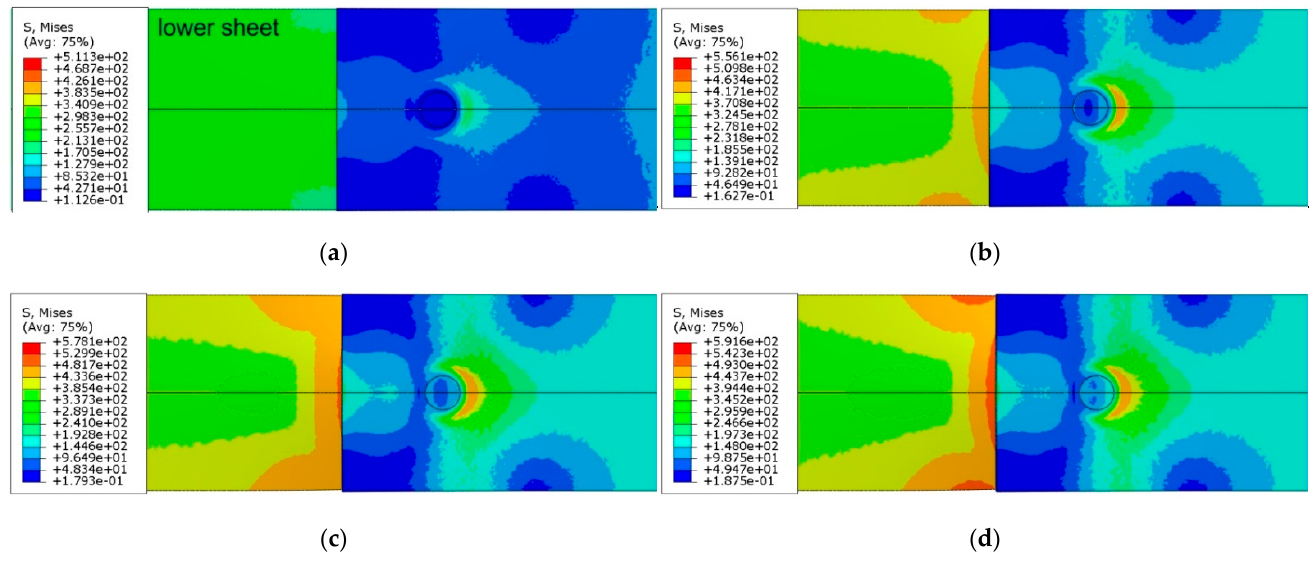
Figure 22. Distribution of equivalent von Mises stress (in MPa) in the RFSSW joint under tensile shear loading at different displacements (view on surface of weld): ( a ) 0.45 mm, ( b ) 0.9 mm, ( c ) 1.35 mm and ( d ) 1.8 mm.